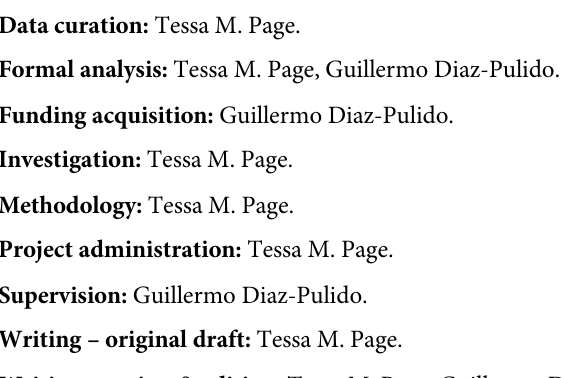
S1 Fig. Diagram of recirculating, purpose-built aquarium system. Diagram shows basic experimental setup including primary holding tank, treatment header sumps (n = 4), and inde- pendent treatment tanks (11 tanks per treatment). S2 Fig. F germlings settled on an acrylic plate from the high temperature (+2.0˚C) and 1 ambient p CO (pH) treatment. 2 S3 Fig. Month-old Sporolithon germlings (F ) under stereomicroscope from ambient tem- 1 perature and high p CO (low pH) treatment. Letters identify individuals that were tracked 2 throughout the experiment for survival and growth. S1 Table. Seawater carbonate system parameters. Asterisk indicates parameters that were calculated using R package seacarb (v 3.2.12). High Mg-calcite was calculated for 16.4% calcite following methods from Diaz-Pulido et al. [16]. S2 Table. Two-way ANOVA for the effects of temperature and p CO on the number of 2 spores released by Sporolithon adults after one month in different temperature and p CO 2 treatments. Counts of spores were taken from an n = 5–6 adults. One outlier was removed from the increased temperature treatment, which was identified using Tukey’s rule and was more than 1.5 X the interquartile